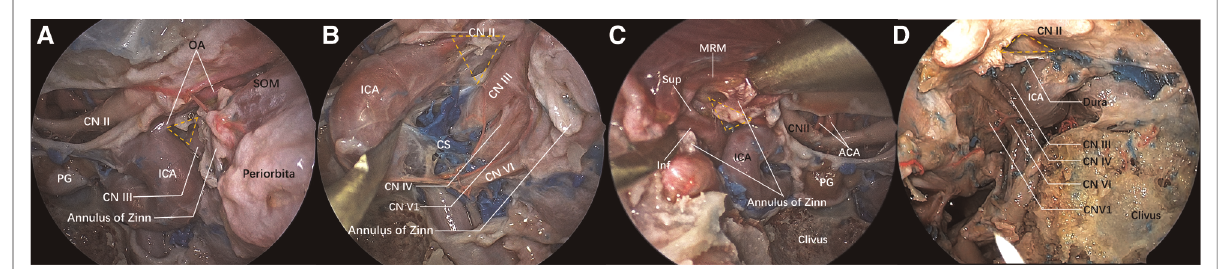
FIGURE 2 Structure adjacent to the “ optic strut triangle ” under the nasal endoscope. The lateral wall of the sphenoid sinus and the orbital apex bone are ground. The yellow dotted triangle is the ground optic strut triangle. ( A ) View of the lateral wall of the left sphenoid sinus under the nasal endoscope. The optic nerve sheath is incised, and the ophthalmic artery emerges from the ICA horizontal segment and enters the orbit below the optic nerve along the upper lateral surface of the optic strut. The other two surfaces of the optic strut are adjacent to the ICA and the oculomotor nerve, respectively. A part of the exposed oculomotor nerve is shown in the fi gure, the space orbit apex is the incised common tendinous ring and orbital periosteum, and the superior oblique muscle is exposed. ( B ) The ICA is displaced medially to expose part of the oculomotor nerve. The nerves emerging from the medial wall of the cavernous sinus are oculomotor nerve, trochlear nerve, ophthalmic nerve and abducent nerve from top to bottom. The oculomotor nerve is closely connected with the optic strut. ( C ) On the other side of the same specimen, the medial rectus muscle is lifted to expose the superior and inferior branches of the oculomotor nerve. ( D ) The optic strut is ground while the dura mater around the optic strut is preserved. The oculomotor nerve, abducent nerve, and trochlear nerve and ophthalmic nerve emerging from the lateral wall of the cavernous sinus are identi fi